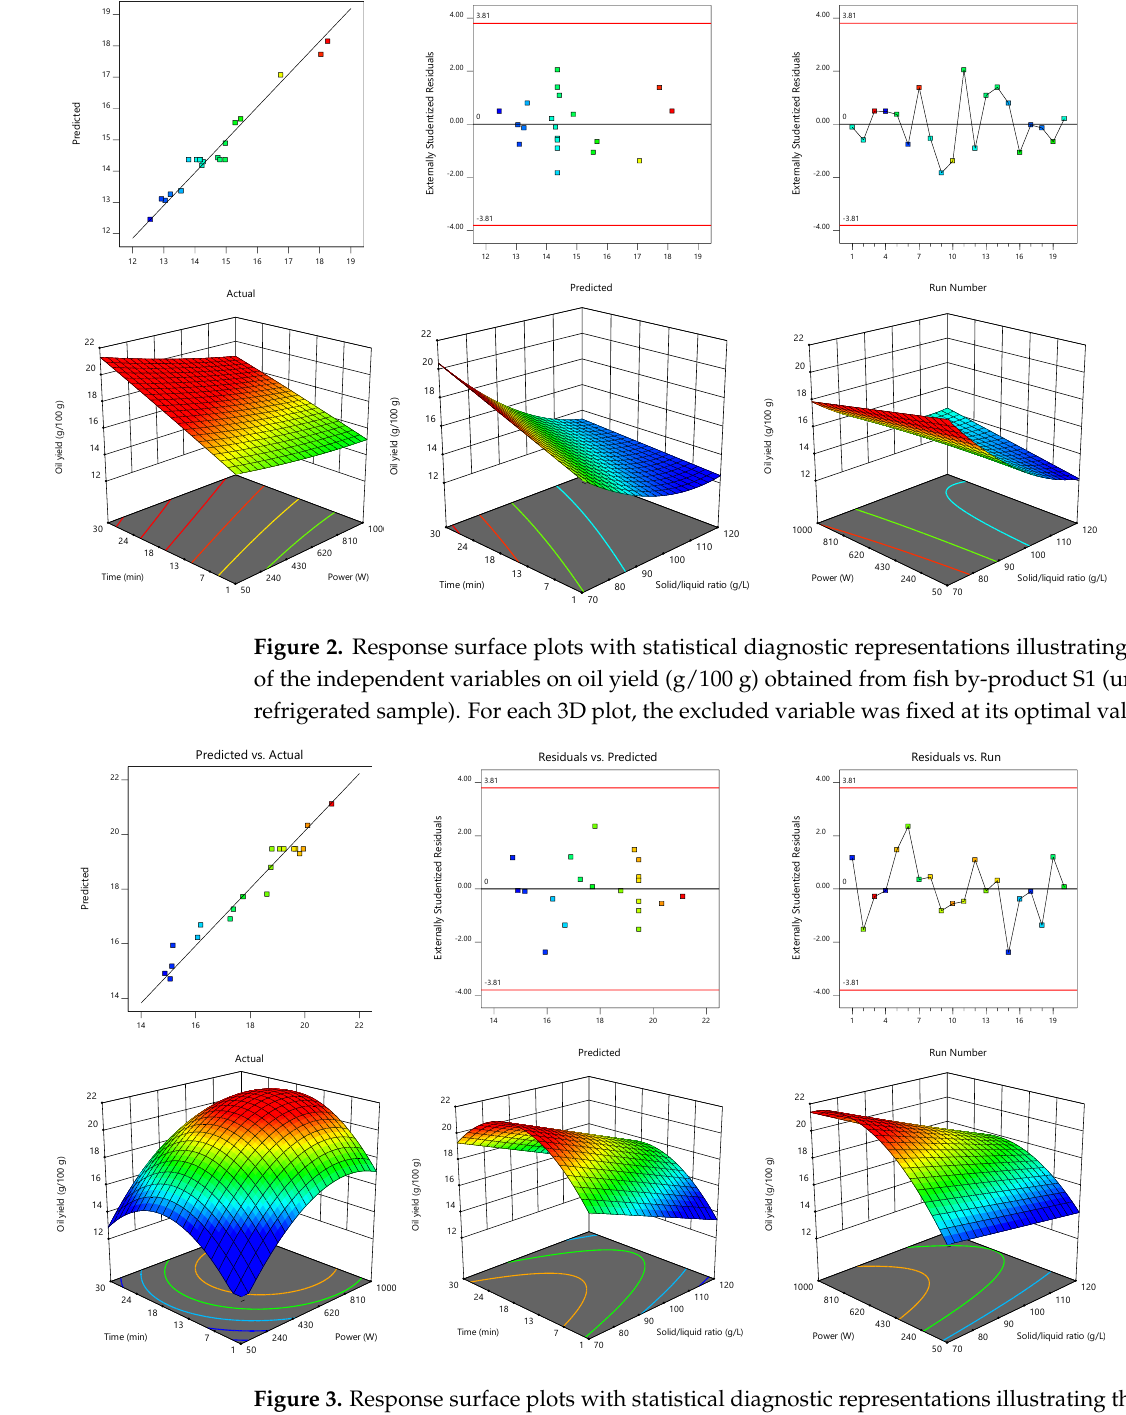
induced the strongest linear effects (1.2), followed by solid/liquid ratio ( − 1.0), and then time (0.52). An interaction effect ( − 0.3) between microwave power and solid/liquid ratio also characterized Equation (7).